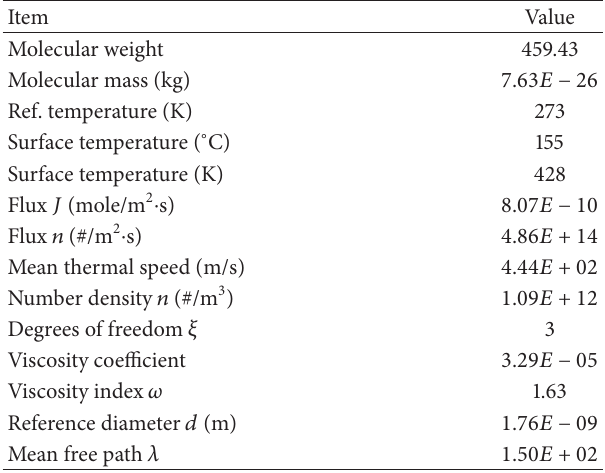
Table 1: The properties of Organic Material